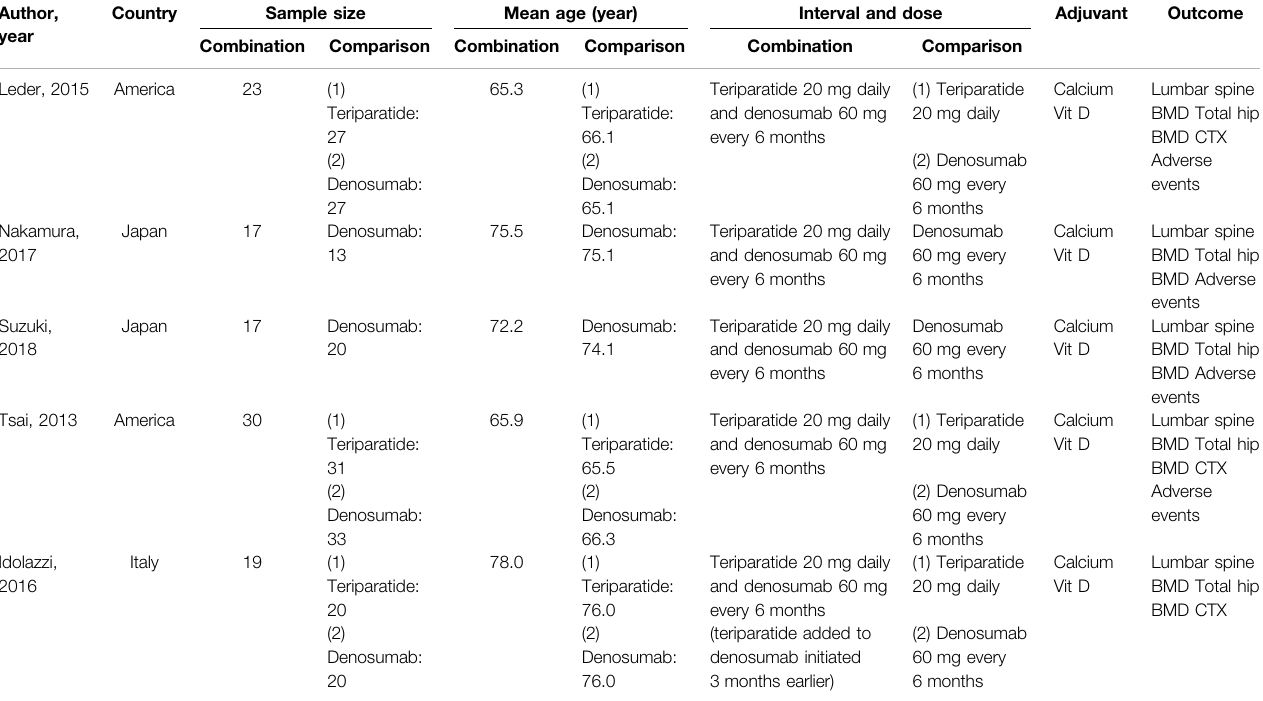
TABLE 1 | Basic characteristics of included